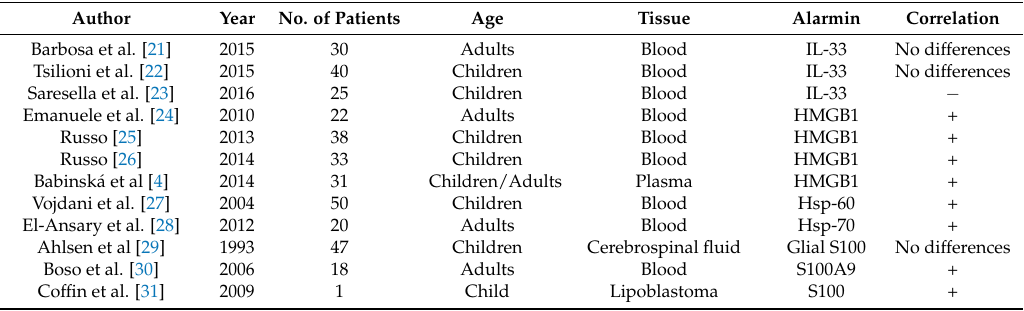
Table 1. List of the original articles concerning alarmins in human autism spectrum disorder (ASD)